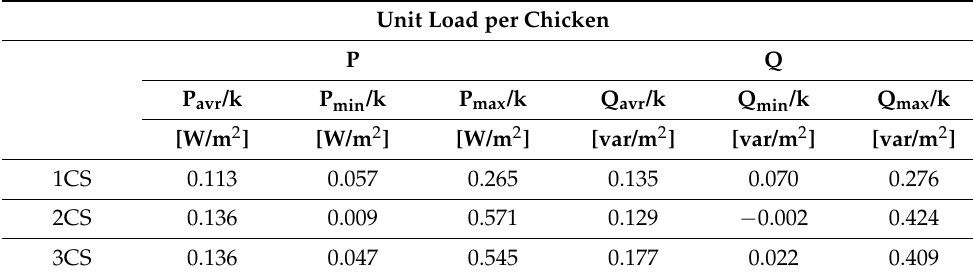
Table 8. Average, minimum, and maximum load of active and reactive power per